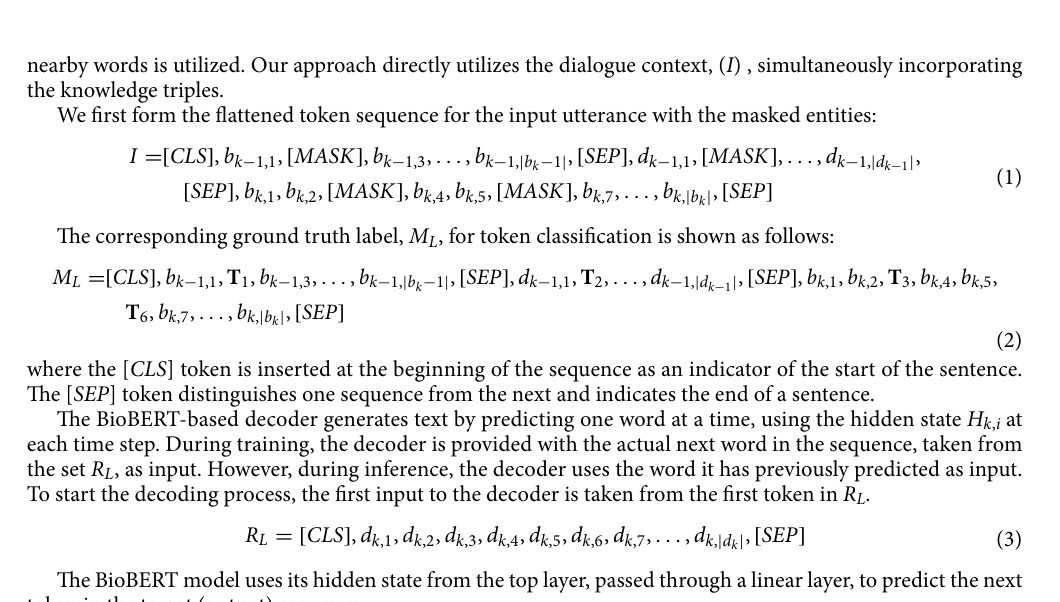
Table 4. Dataset details.